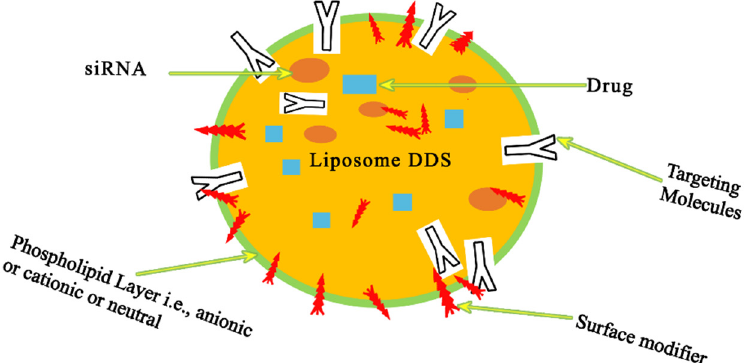
Figure 4. Liposome-based carriers are sphere-shaped vesicles made of synthetic or natural phospholipids. Surface-modifier and -targeting groups can be conjugated to the outer surface. Phospholipids naturally form a bilayer upon aqueous dispersion, with the non-polar tails facing one other and the polar heads facing towards the aqueous phase. Hydrophilic molecules and RNAs are incorporated into the resulting inner core, while hydrophobic molecules are encapsulated in the lipid bilayer. Adapted and modified from [81] under the Creative Commons license.